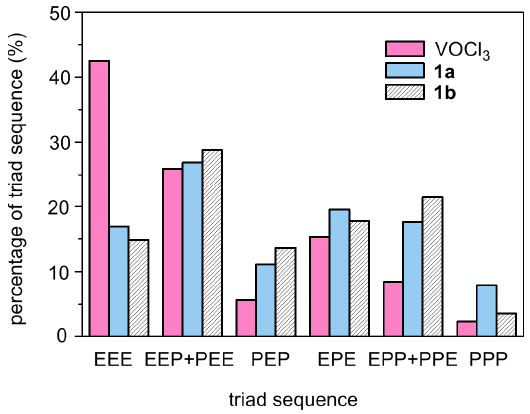
Figure 6. Monomer sequence distribution of ethylene/propylene copolymers determined from 13 C NMR spectra (VOCl 3 , Run 3; 1a , Run 6; 1b , Run 10 in Table 1).